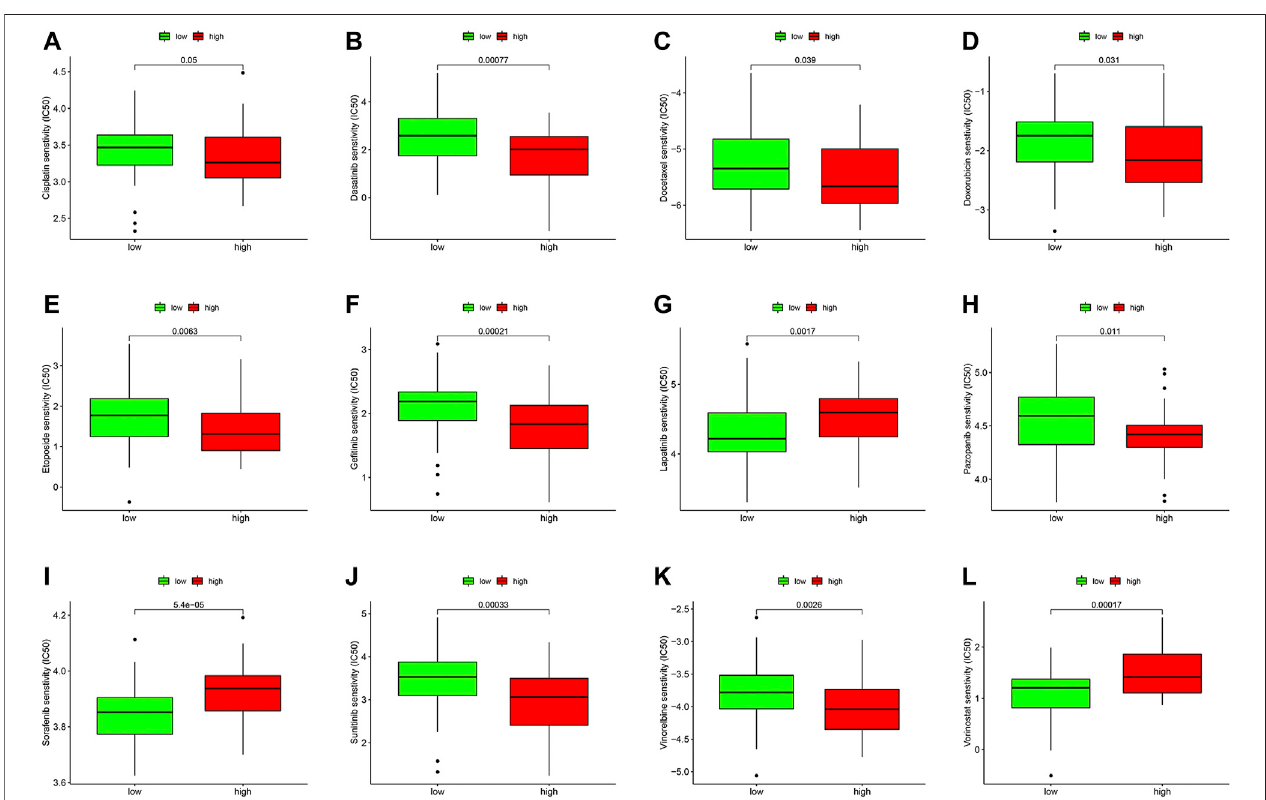
FIGURE 8 | Drug sensitivity analysis between the high- and low-ferroptosis groups. Box plots demonstrated the differences of IC50 in Cisplatin (A) , Dasatinib (B) , Etoposide (C) , Ge fi tinib (D) , Lapatinib (E) , Pazopanib (F) , Sorafenib (G) , Sunitinib (H) , Vorinostat (I) , Docetaxel (J) , Vinorelbine (K) , and Doxorubicin (L) . The lower the IC50, the more sensitive the drug